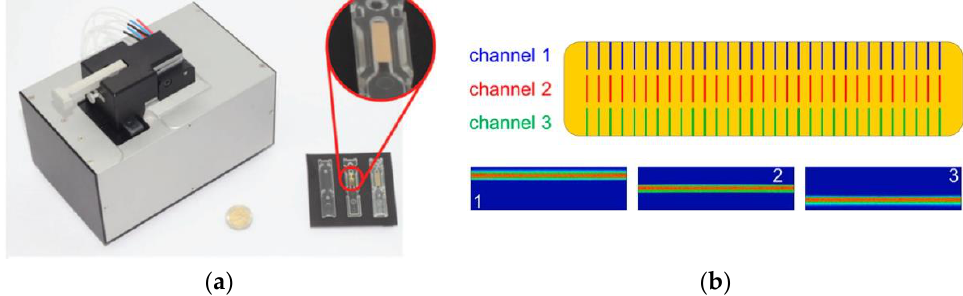
Figure 4. ( a ) Fraunhofer compact SPR biosensor (left) with chips and flow cells (right) and ( b ) schematic representation of the arrangement of the three 1D spot arrays (channel 1, channel 2 and channel 3) on the gold surface illuminated by three side-by side distinct stripes lights (1, 2 and 3). Reproduced with permission from [25,72]. Copyright John Wiley and Sons, 2011 and Walter De Gruyter GmbH, 2016.